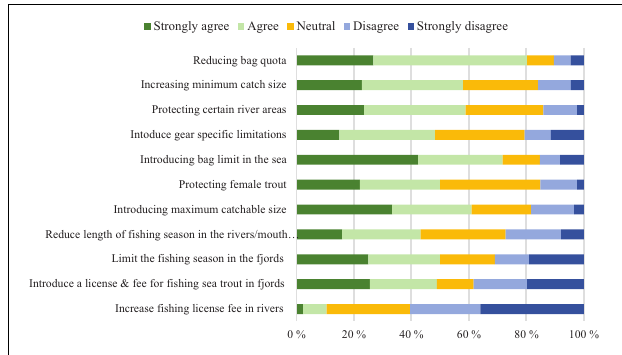
FIGURE 5 | Anglers’ view to future fishing regulations and